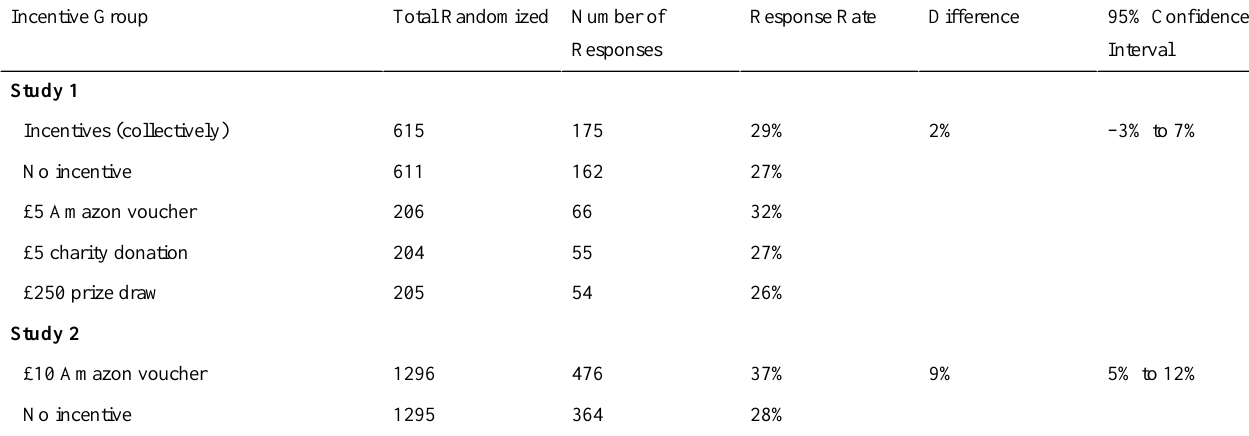
Table 2. Response rates for incentive groups in study 1 and study 2